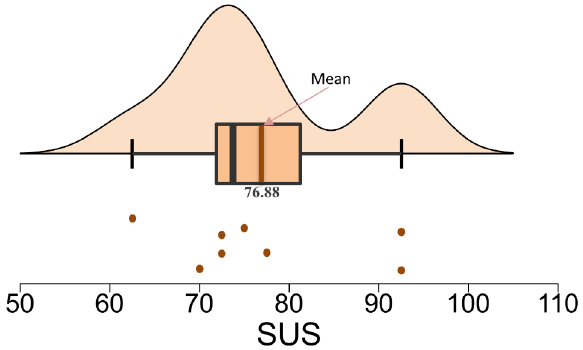
Figure 6. Participants’ responses to the System Usability Scale (SUS) questionnaire.